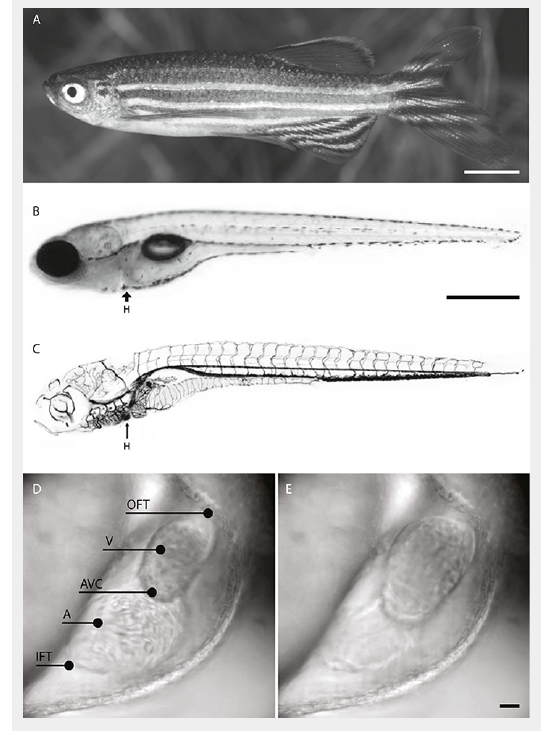
A: Adult male zebrafish. Scale bar 5 mm. B: Bright-field image of a 7 dpf (days post-fertilisation) zebrafish larva. Scale bar: 500 µm. C: The position of the heart (H) in the cardiovascular system of a zebrafish larva. Images adapted from Brown University (Isogai et al. 2001 [66]) and Interactive Atlas of Zebrafish Vascular Anatomy (zfish.nichd.nih.gov). D–E: Bright-field images of the 2 dpf zebrafish heart. D: Systole. E: Diastole. Inflow tract (IFT), atrium (A), atrioventricular canal (AVC), ventricle (V), outflow tract (OFT). Scale bar: 20